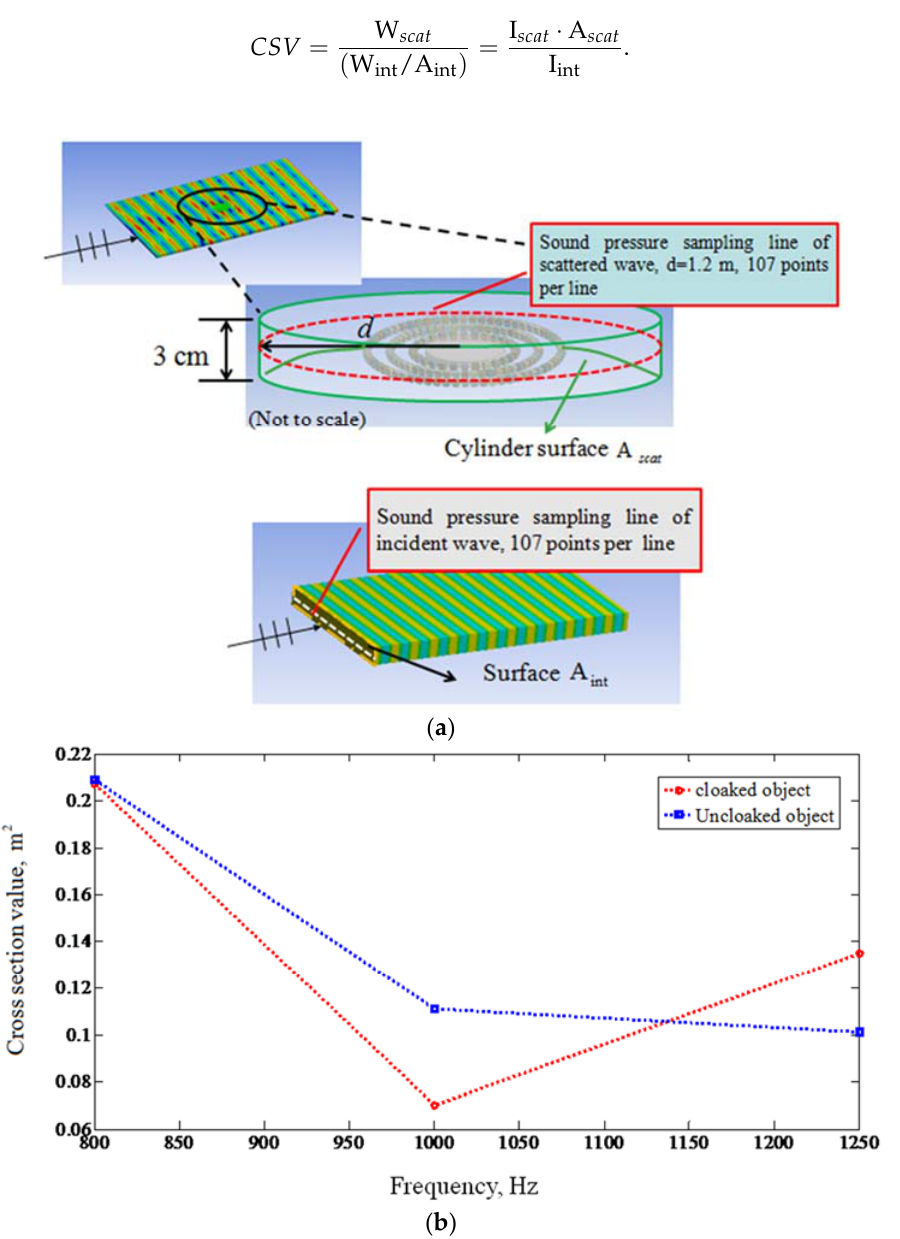
Figure 22. The sound pressure sampling line, sampling surface, and results for the cross-section value ( CSV ) calculation of the scattered field: ( a ) the enclosed cylinder surface and sampling line positions; ( b ) the normalized sound field (scattered field) CSV results of cloaked and uncloaked cases. The sound pressure values for calculating I int and I scat are sampled at straight and circular